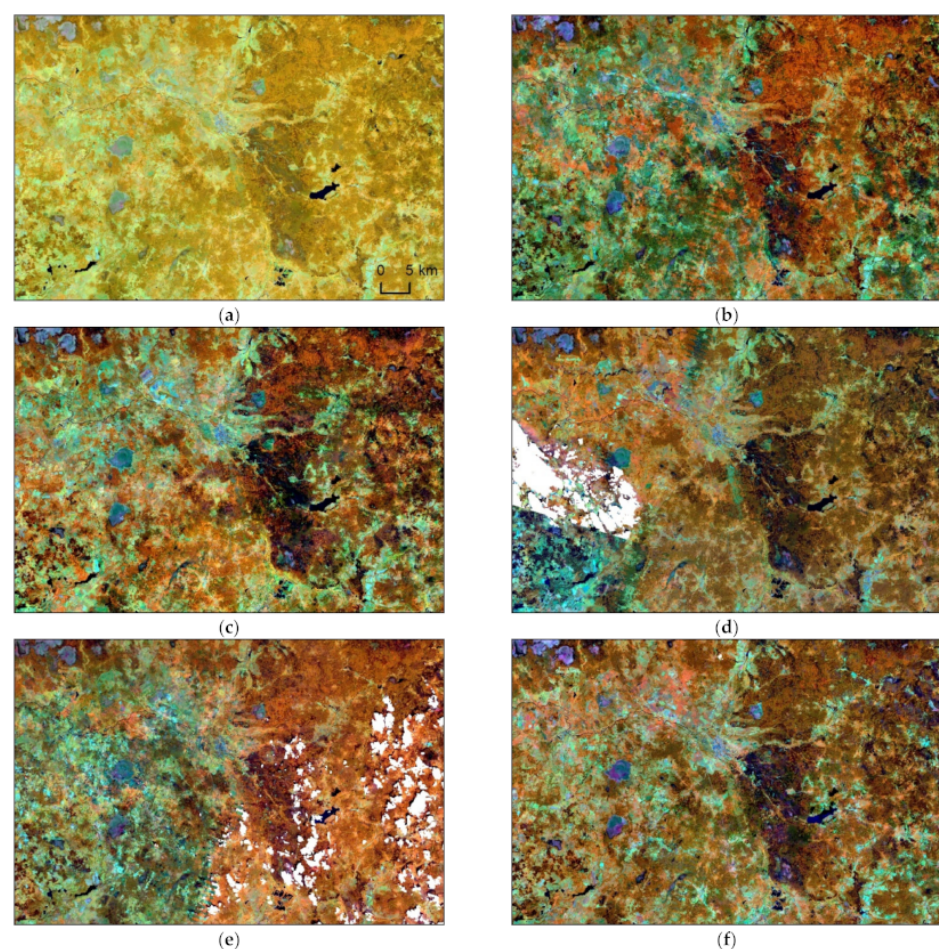
Figure 5. Fragments of the generated Landsat mosaics (NIR-SWIR1-Red synthesis): ( a ) 2006–2010 five-year mosaic; ( b ) 2006 annual mosaic; ( c ) 2007 annual mosaic; ( d ) 2008 annual mosaic; ( e ) 2009 annual mosaic; ( f ) 2010 annual mosaic. Table 3. Goodness-of-fit metrics statistics of GAMs used for Landsat mosaics normalization.